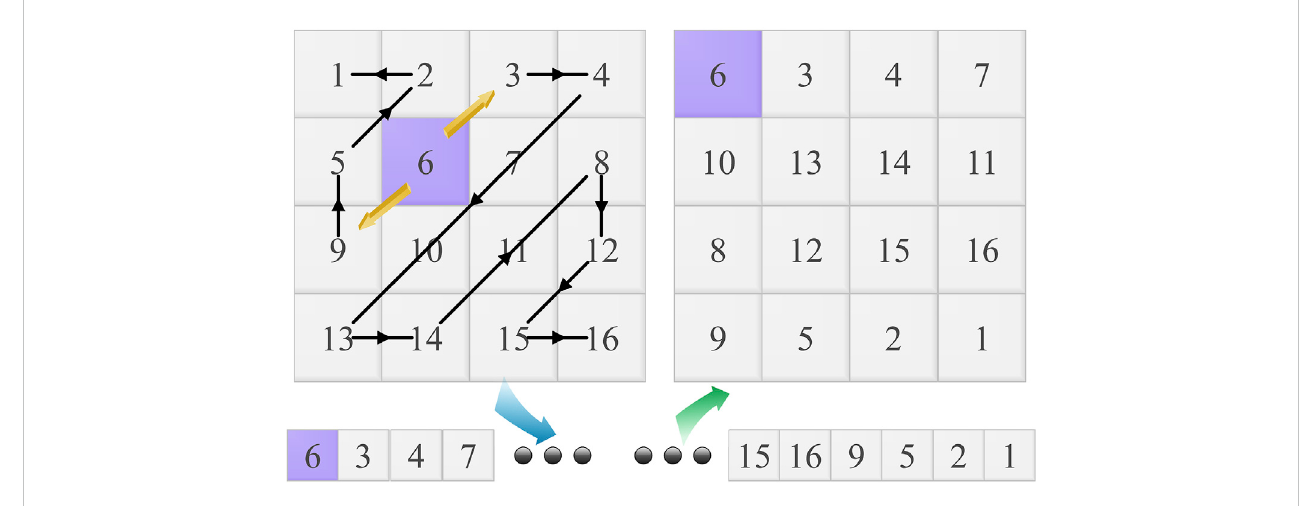
FIGURE 1 Zigzag scrambling transform principle.